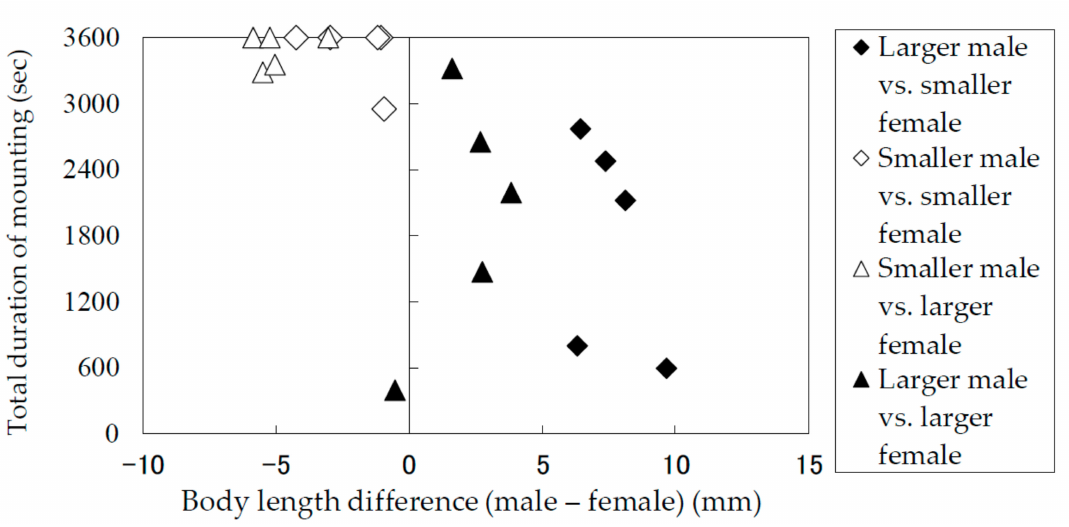
Figure 5. Total mounting durations of Rosalia batesi adult pairs with different body lengths (male body length—female body length).